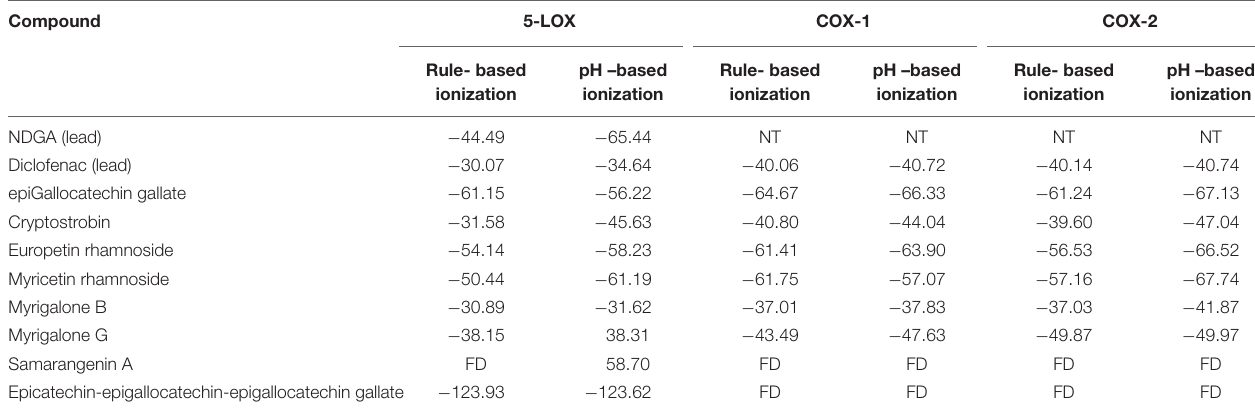
TABLE 5 | Free binding energies (kcal/mol) of the identified compounds in 5-LOX, COX-1 and COX-2 active sites using molecular modeling experiments.